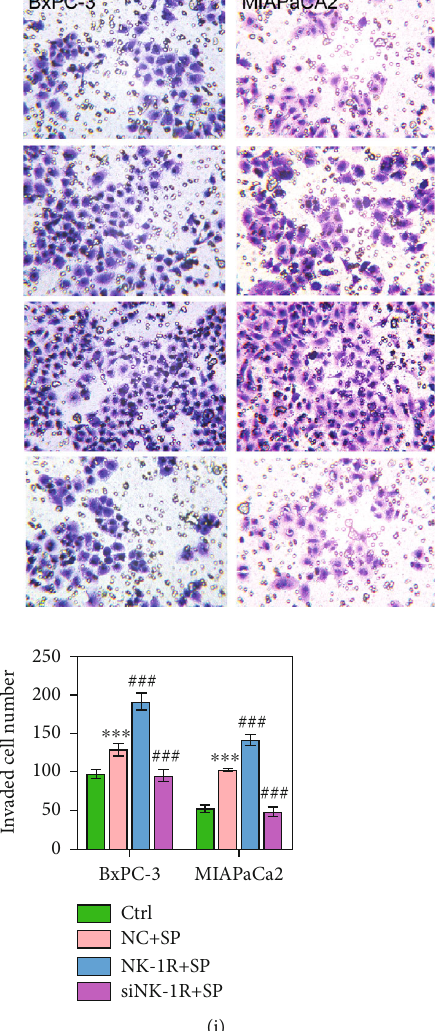
Figure 4: NK-1R positively regulated the proliferation, migration, and invasion of pancreatic cancer cells. (a, b) The levels of NK-1R gene and protein expression in the Ctrl, NC +SP, NK-1R +SP, and siNK-1R +SP groups. (c, d) The levels of NF- κ B p65, AKT, and p-AKT protein expression were assessed in di ff erent groups. (e, f) Cell proliferation rates in the Ctrl, NC+ SP, NK-1R+ SP, and siNK-1R+ SP groups were analyzed by CCK-8 and EdU staining assays. (g, h) Transwell and wound-healing assays were performed to evaluate cell migration ability. (i) Cell invasion was assessed by the Transwell assay. ∗ P < 0 : 05 , ∗∗∗ P < 0 : 001 vs. Ctrl. # P < 0 : 05 , ### P < 0 : 001 vs. NC +SP